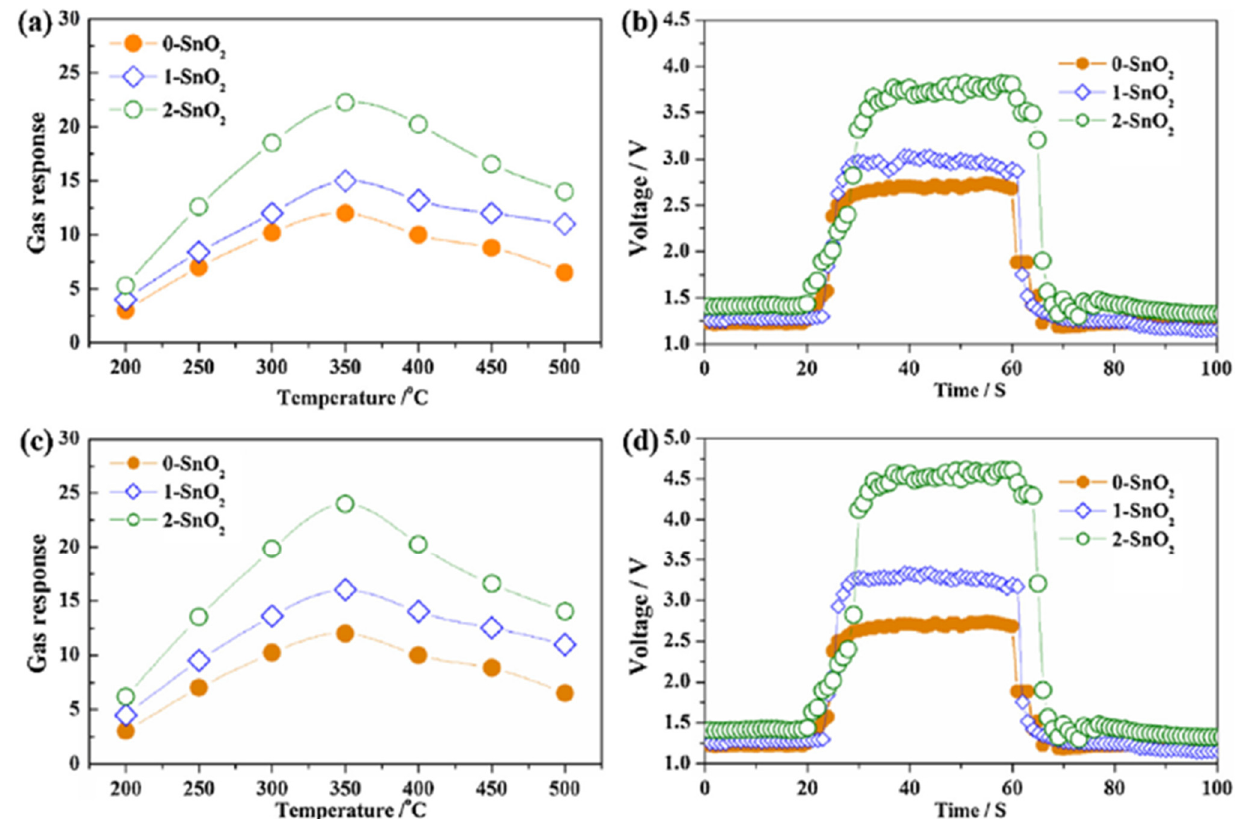
Figure 24. ( a ) Gas response of the three sensors exposed to 400 ppm H 2 concentration at different temperatures in an atmospheric environment. ( b ) The response-recovery curve of the three sensors under 400 ppm H 2 concentration at 350 °C in an atmospheric environment. ( c ) Gas response of the three sensors exposed to 400 ppm H 2 concentration at different temperatures in a vacuum environment. ( d ) The response-recovery curve of the three sensors under 400 ppm H 2 at 350 °C in a vacuum environment [106]. Copyright (2019), with permission from Elsevier.